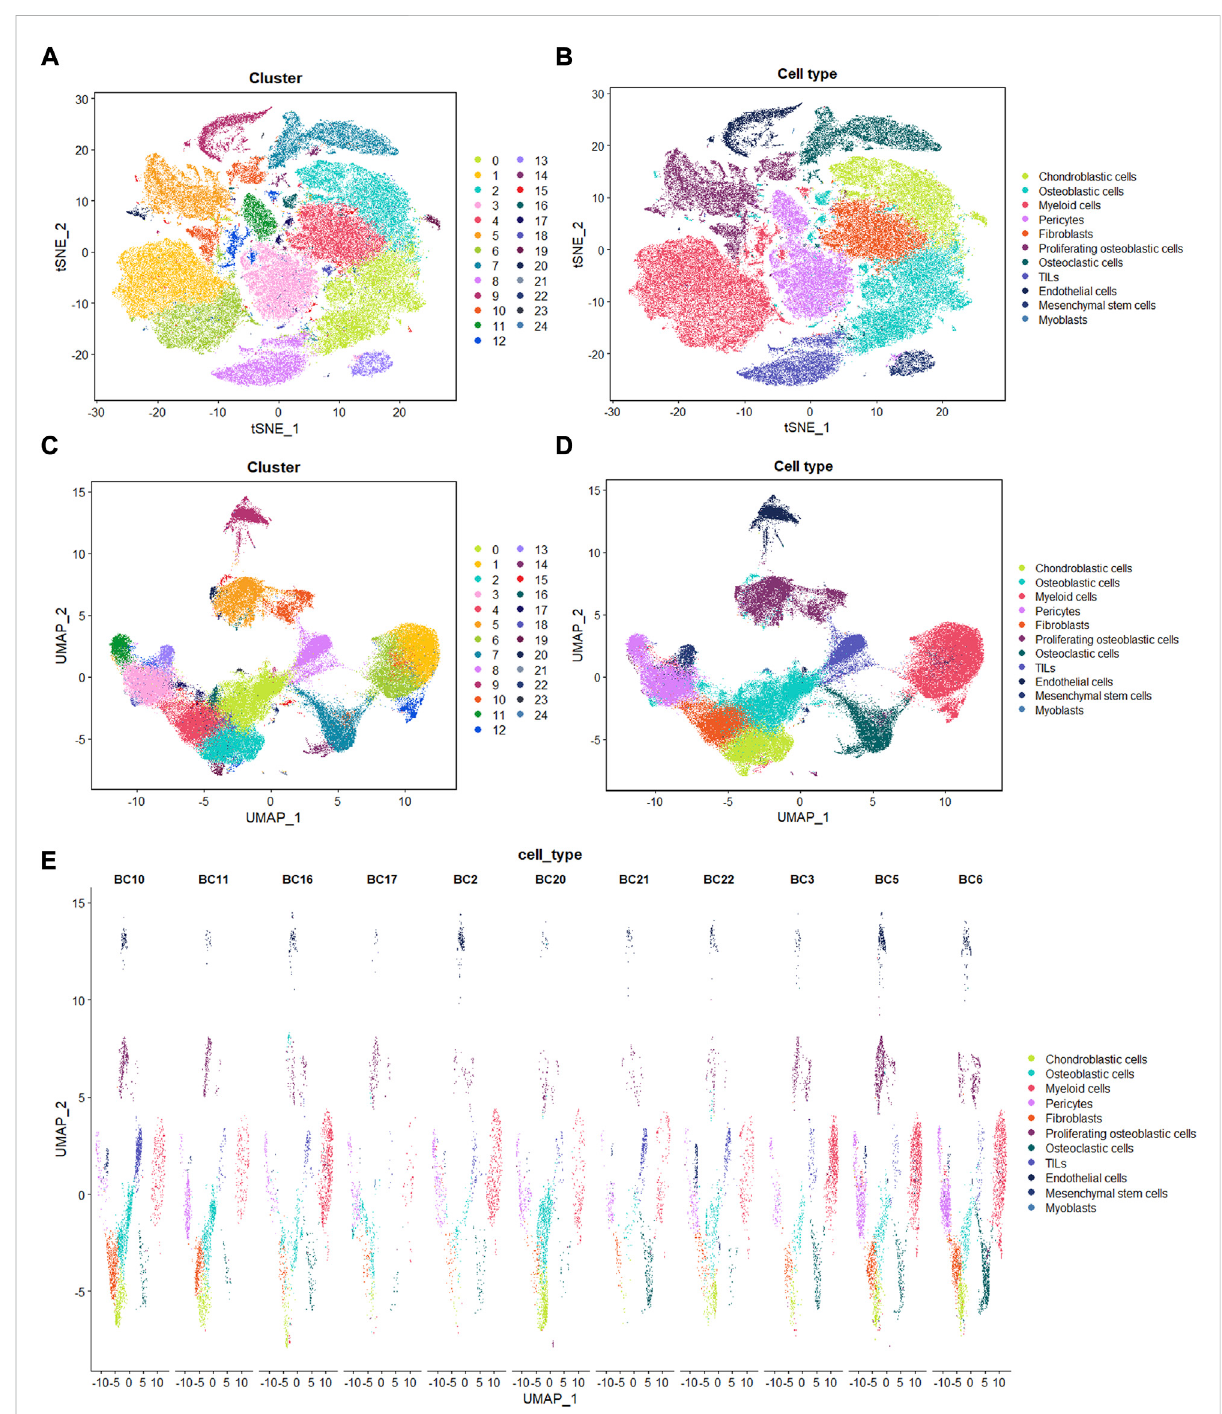
FIGURE 3 Single-cell transcriptomic analysis of OS lesions. (A,C) : t-SNE and UMAP analysis showing the results of descending clustering. (B,D,E) : t-SNE and UMAP analysis showing the results of annotation of cell subpopulations in cells of OS